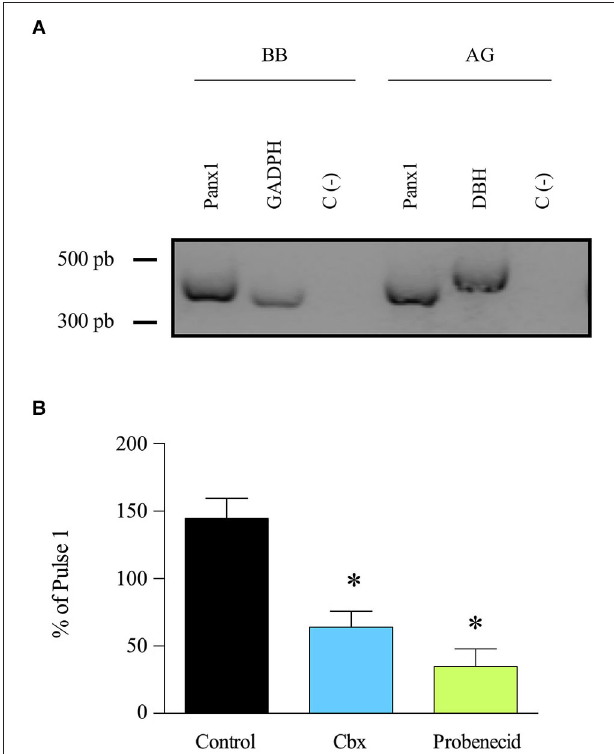
FIGURE 1 | Panx1 is expressed in adrenal gland and participates in the release of catecholamines . (A) Expression of Panx1 was evaluated by RT-PCR using Panx1 primers. The RT-PCR was performed on mRNA extracted from bovine brain (BB) (positive control) and adrenal gland (AG). GADPH and DBH were used as amplification controls; they lead to the generation of 334 pb and 480 pb transcripts, respectively. A negative control without template was also included (C-). The presence of Panx1 transcript (396 pb) was detected in bovine brain as well as in adrenal gland. (B) Entire adrenal glands were perfused with Kreb’s solution for 1 h, and then the release of catecholamines was induced by a 2 min pulse of the nicotinic agonist DMPP (50 µ M). Fifteen minutes before the second pulse, the glands were treated with Cbx (5 µ M) or probenecid (200 µ M). The drugs were maintained in the perfused solution during the entire sample recollection. Absorbance of the catecholamine oxidation products was measured at 540 nm. Data, expressed as the percentage of catecholamines secreted during the second pulse with respect to the first pulse, are means ± SEM of control glands ( n = 10), or glands treated with carbenoxolone (Cbx) ( n = 9) or probenecid ( n = 10). * p < 0.05 compared with control glands (Krukal-Wallis